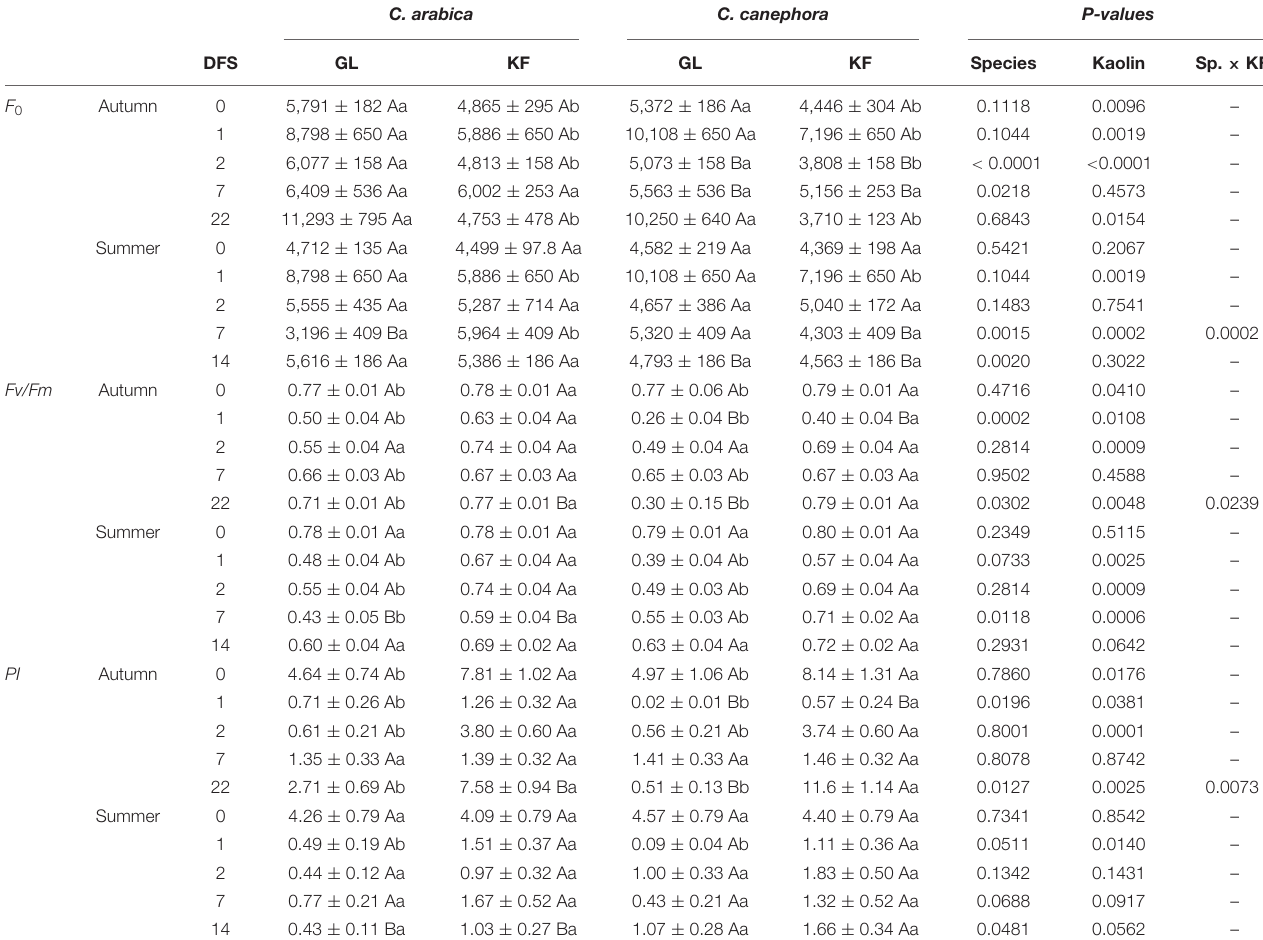
Means ± S.E. followed by different lowercase letters indicate statistically different values between kaolin treatments within the same species, while uppercase letters indicate differences between two coffee species within the same kaolin treatment, detected by the ANOVA and Tukey test (n = 5). P-values for effects of species, kaolin, and their interactions are indicated for days of exposure to full sunlight